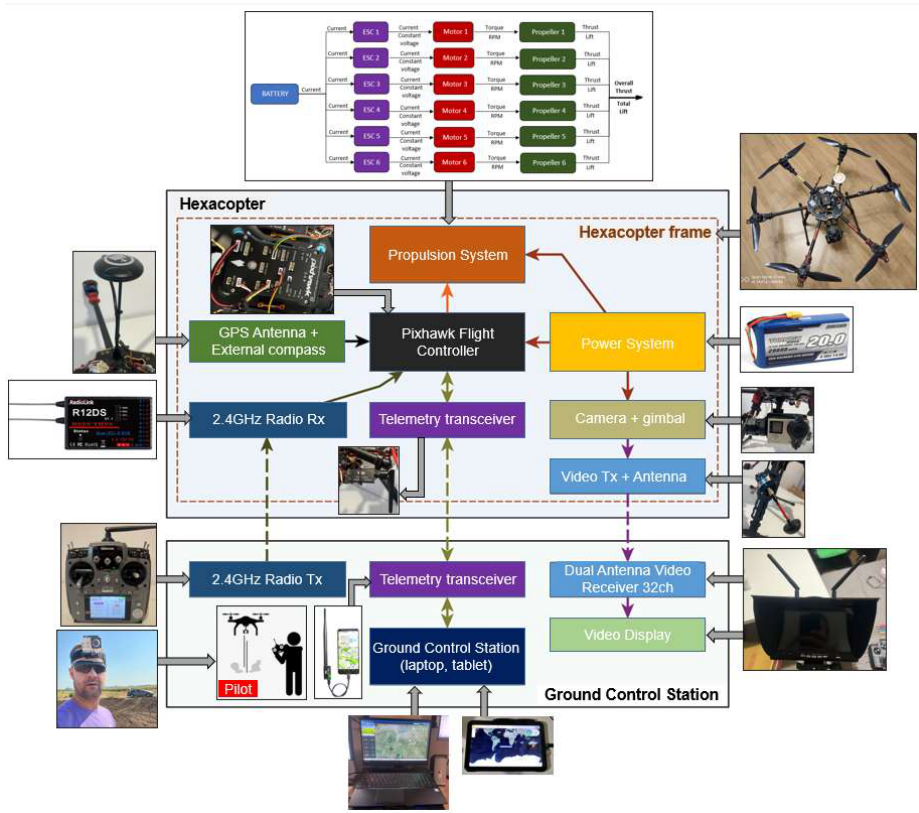
Figure 6. Blocd diagram of hexacopter platform.